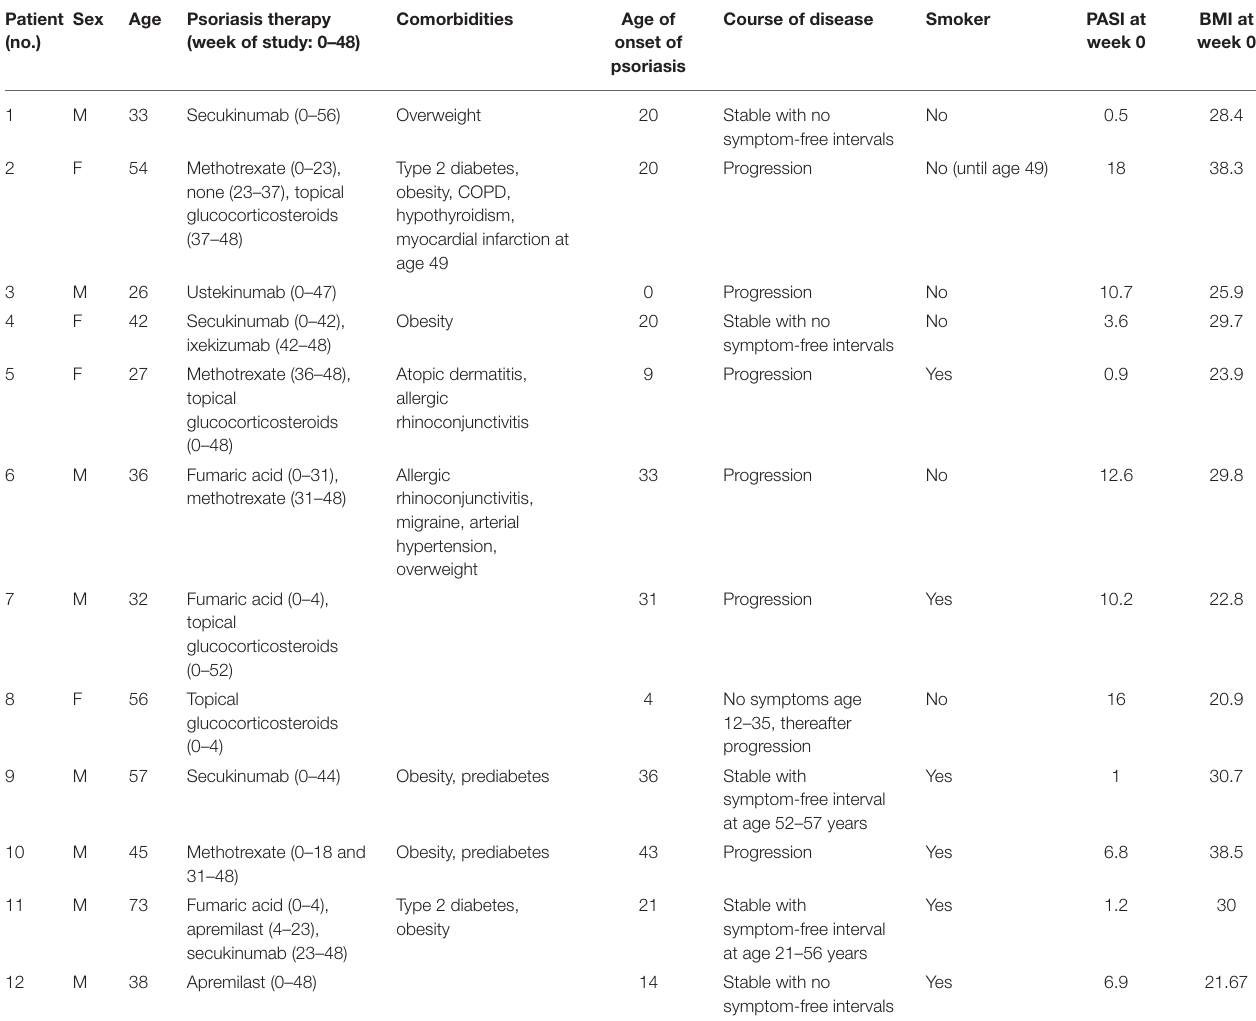
TABLE 1 | Clinical characteristics of the patients included in the study. Patient